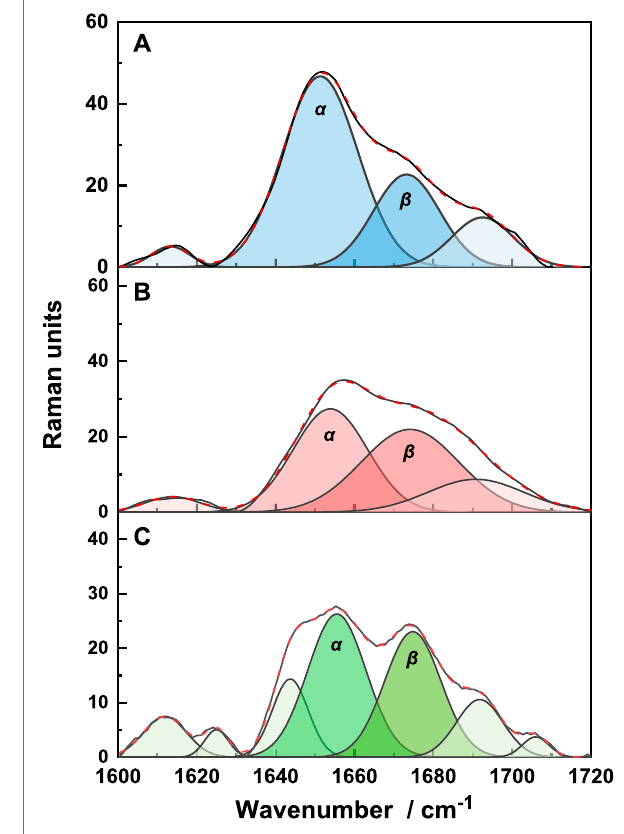
FIGURE 5 | The deconvolution of the amide I region of the Raman spectra of natural wool (A) , K-C (B) , and K-M (C)